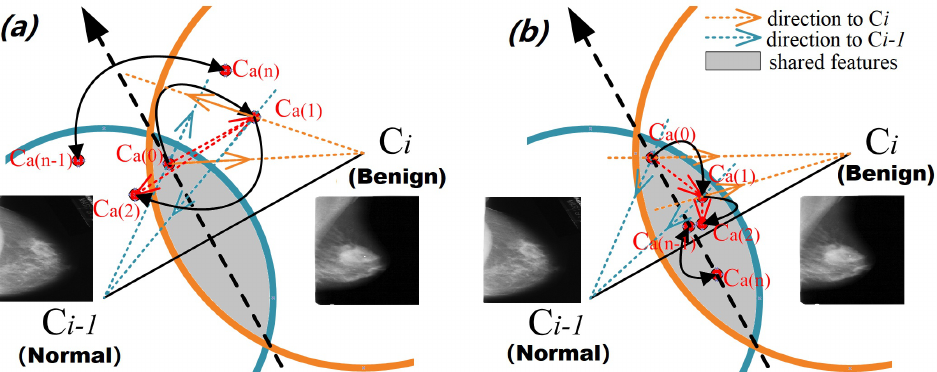
Figure 4. When two adjacent categories pull the center of the shared features, the resultant force decides where the center will finally stay. ( a ) When using one-hot labels, if the initial center of the shared features is C a ( 0 ) , the resultant vector of the puling forces toward C i and C i − 1 will make the center slip from C a ( 0 ) to C a ( 1 ) . Finally, the center of the shared features will move close to either C i or C i − 1 . ( b ) However, if we use the Gaussian labels, the center of the shared features will finally vibrate in the middle between C i and C i − 1